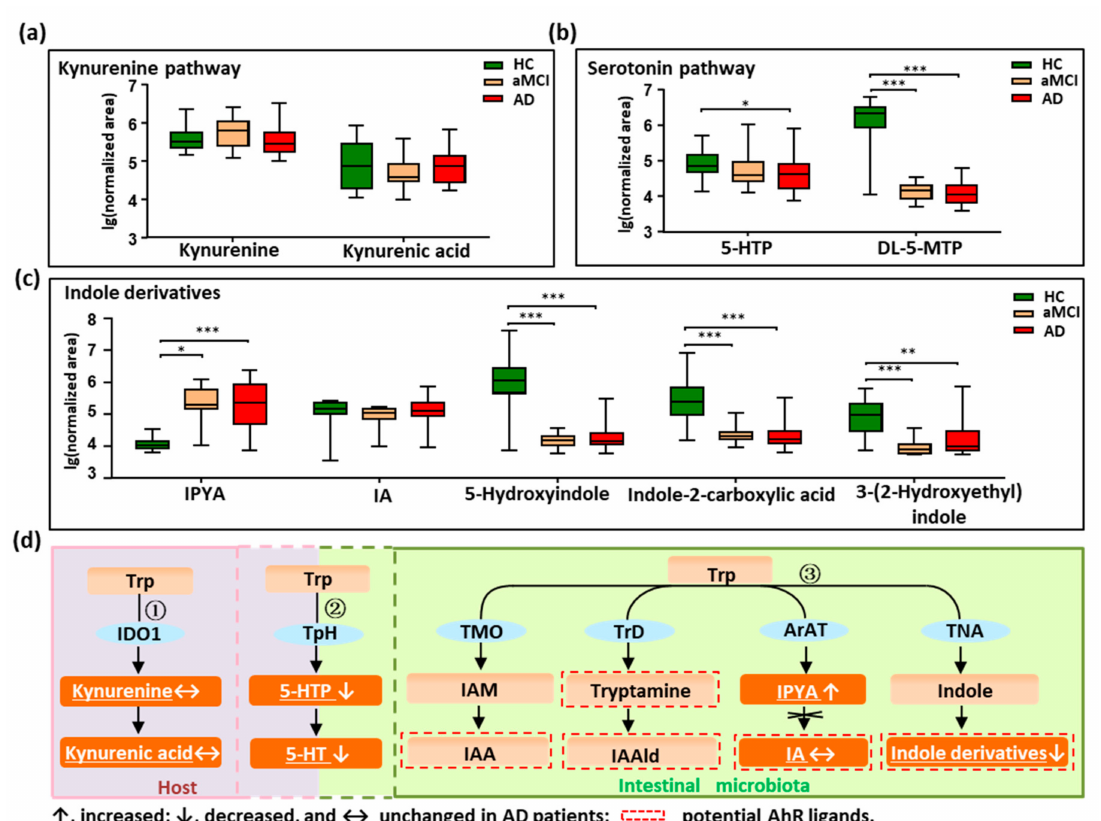
Figure 2. Dysregulation of fecal tryptophan metabolic pathway in AD patients. ( a – c ) Comparison of detected tryptophan metabolites in the kynurenine pathway, serotonin pathway, and indole derivatives among AD, aMCI, and HC groups. ( d ) There are three major tryptophan metabolism pathways: 1 (cid:13) Kynurenine pathway mainly occurs in the liver or extra- hepatic organs; 2 (cid:13) Although neurotransmitter serotonin (5-hydroxytryptamine [5-HT]) can be synthesized in the brain, 90% of the body’s 5-HT is produced in the gut; 3 (cid:13) Tryptophan was directly transformed into indole and its derivatives in the gut controlled by gut microbiota, and many of the indole derivatives are potential AhR ligands. The detected tryptophan metabolites in the current study were marked with a white color and underlined. Note: Data are given as median with range. p values were determined by one-way ANOVA or Kruskal–Wallis test. * p < 0.05; ** p < 0.01; *** p <